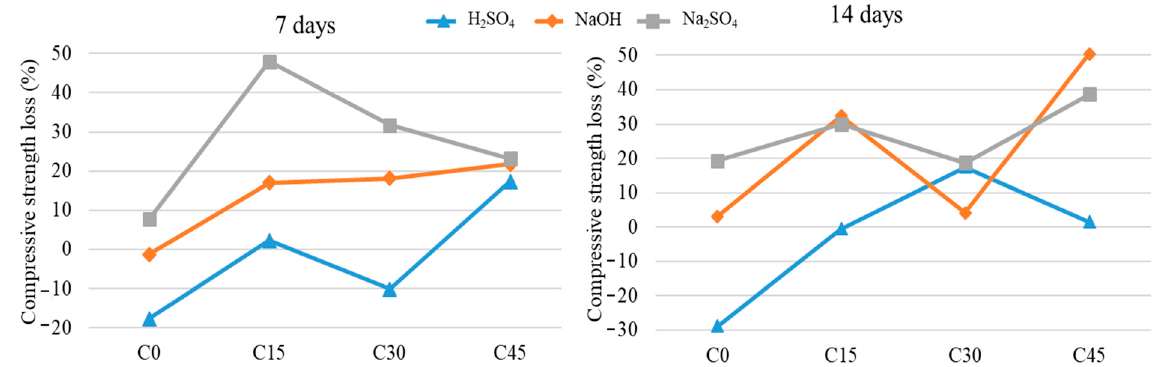
Figure 14. Changes in compressive strength of Portland cement samples containing waste in different proportions after immersion in corrosive media after 7 and 14 days, compared to the non-immersed samples.